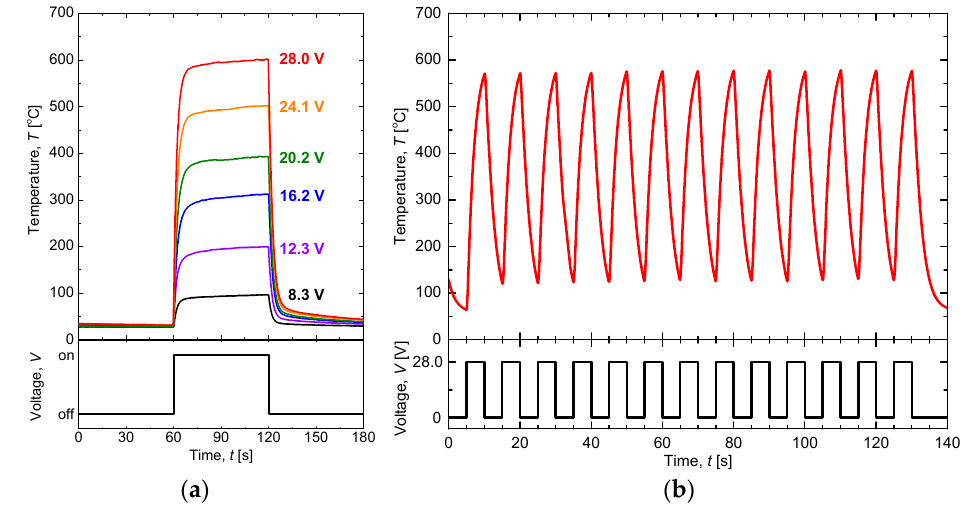
Figure 5. ( a ) Temperatures of the sensor under single-pulse voltage of 60 s in width and various voltage amplitudes applied. ( b ) Temperature of the sensor under cyclic 28.0 V pulse with width of 5 s and cycle time of 10 s. Both measurements are performed in air.